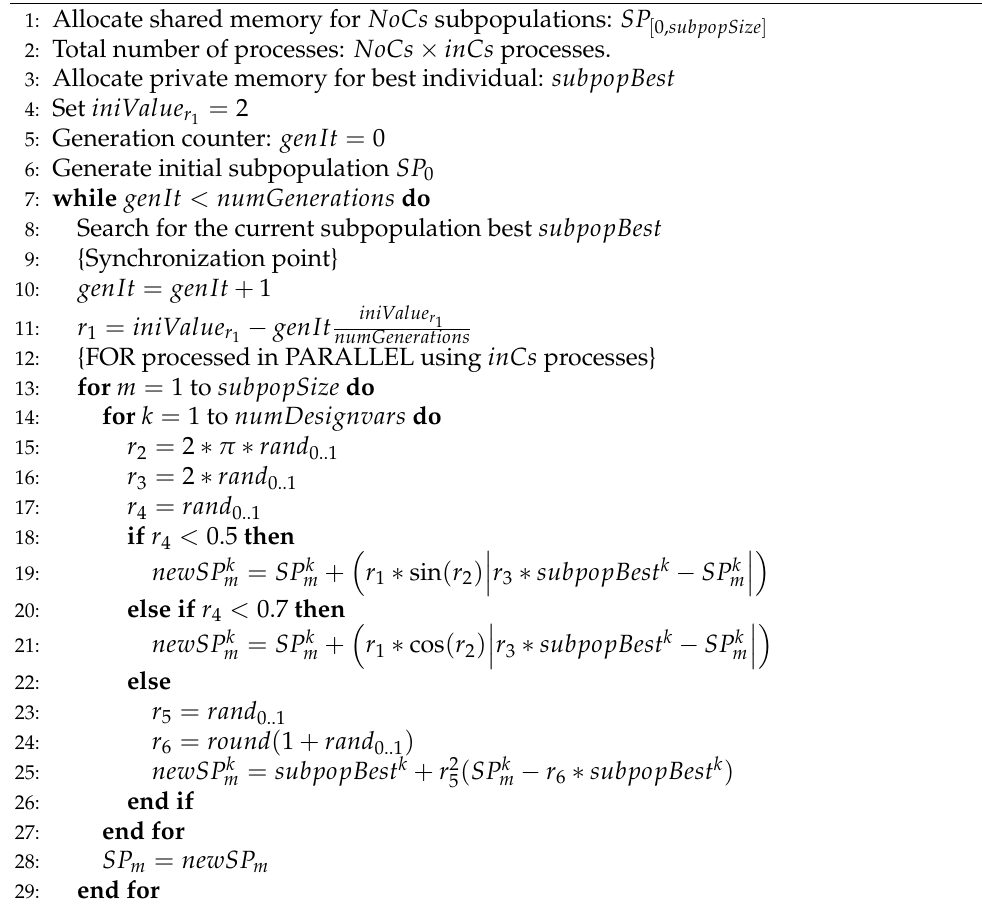
Algorithm 6 Two-level parallel